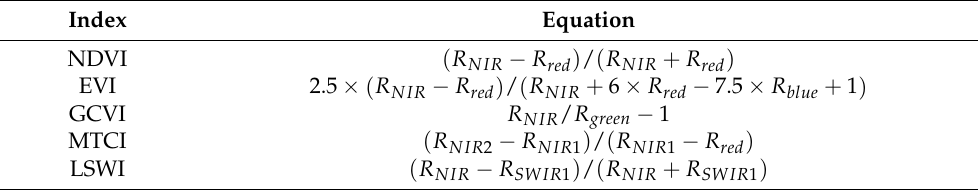
Table 2. Equations of selected vegetation indices. R x represents the reflectance of band x of